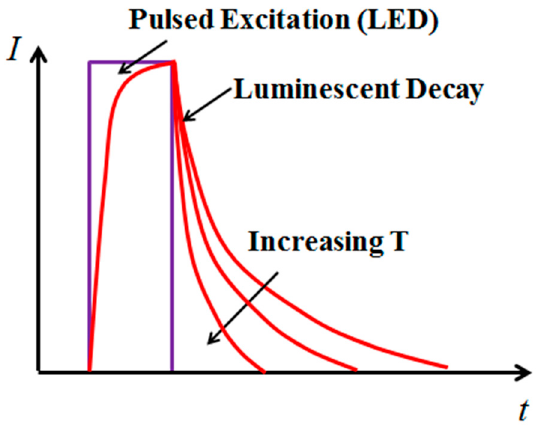
Figure 3. Principle of lifetime-based temperature sensing using phosphors.